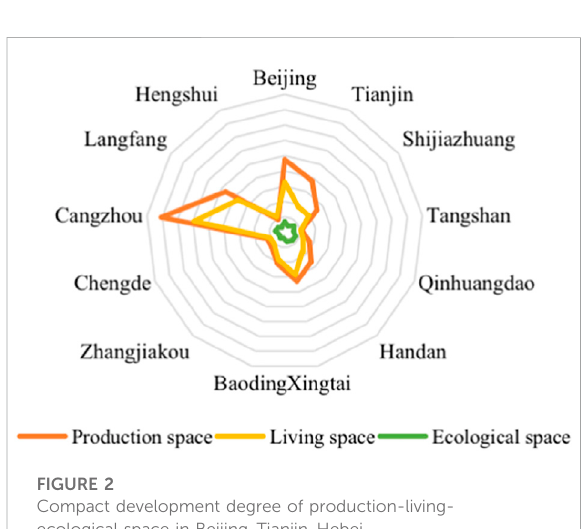
FIGURE 4 Secondary indicators of Degree of compactness of production space in Beijing-Tianjin-Hebei.